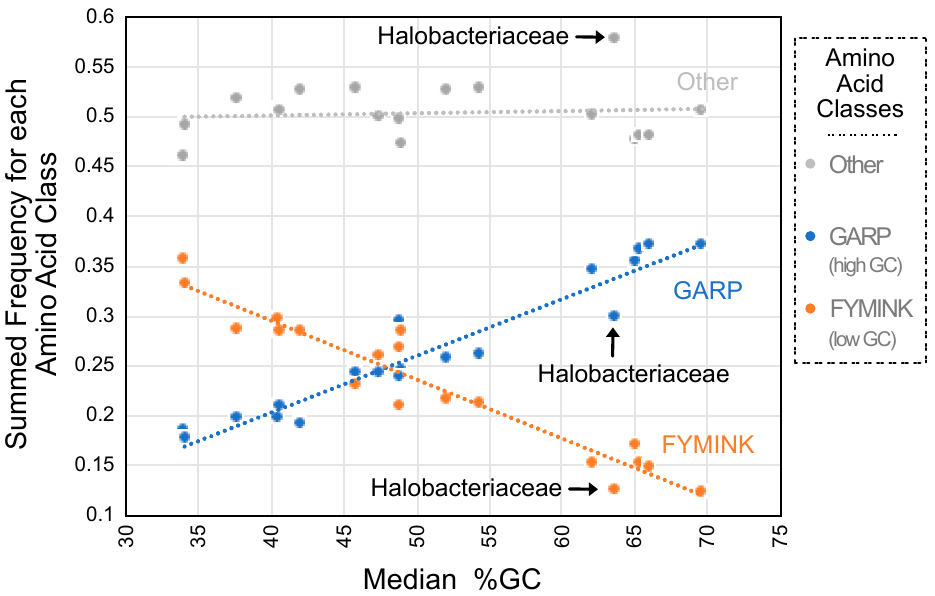
Figure 2. ML estimates of equilibrium amino acid frequencies are related to genomic GC content. The summed equilibrium frequencies for each amino acid class corresponded to values for the general models. We considered three amino acid classes: (1) GARP amino acids (glycine, alanine, arginine, and proline; encoded by GC-rich codons), (2) FYMINK amino acids (phenylalanine, tyrosine, methionine, isoleucine, asparagine, and lysine; encoded by GC-poor codons), and other amino acids. Summed equilibrium frequencies for GARP amino acids had a strong positive relationship with GC content ( f GARP = 0.0057[%GC] − 0.0245; r 2 = 0.9222; indicated using the dashed blue line), whereas summed equilibrium frequencies for FYMINK amino acids had a strong negative relationship with GC content ( f FYMINK = − 0.0059[%GC] + 0.5321; r 2 = 0.9183; indicated using the dashed orange line). Sums of equilibrium frequencies for the remaining amino acids were unrelated to genomic GC content (indicated using the dashed gray line). Halobacteriaceae, which had the largest deviation from the line for other amino acids, is indicated on the graph (the deviation in the “other” category is positive, and this is likely the reason for the negative deviations in both the GARP and the FYMINK categories). Similar data for the individual amino acids involved in REs that exhibited large differences between high-GC and low-GC bacteria are presented in Supplementary Figure S1.